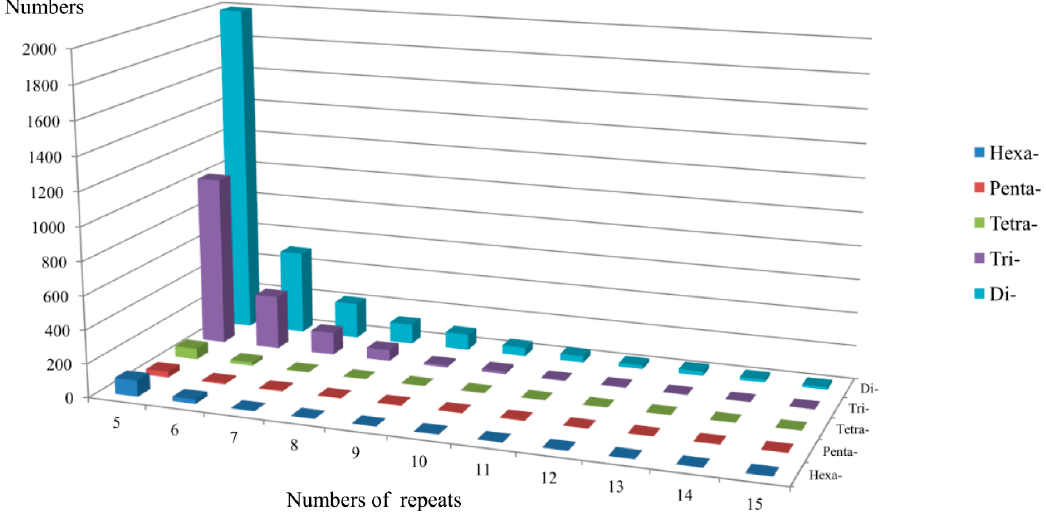
Figure 1. Frequency distributions of various Amentotaxus formosana EST-SSRs with different numbers of repeats.